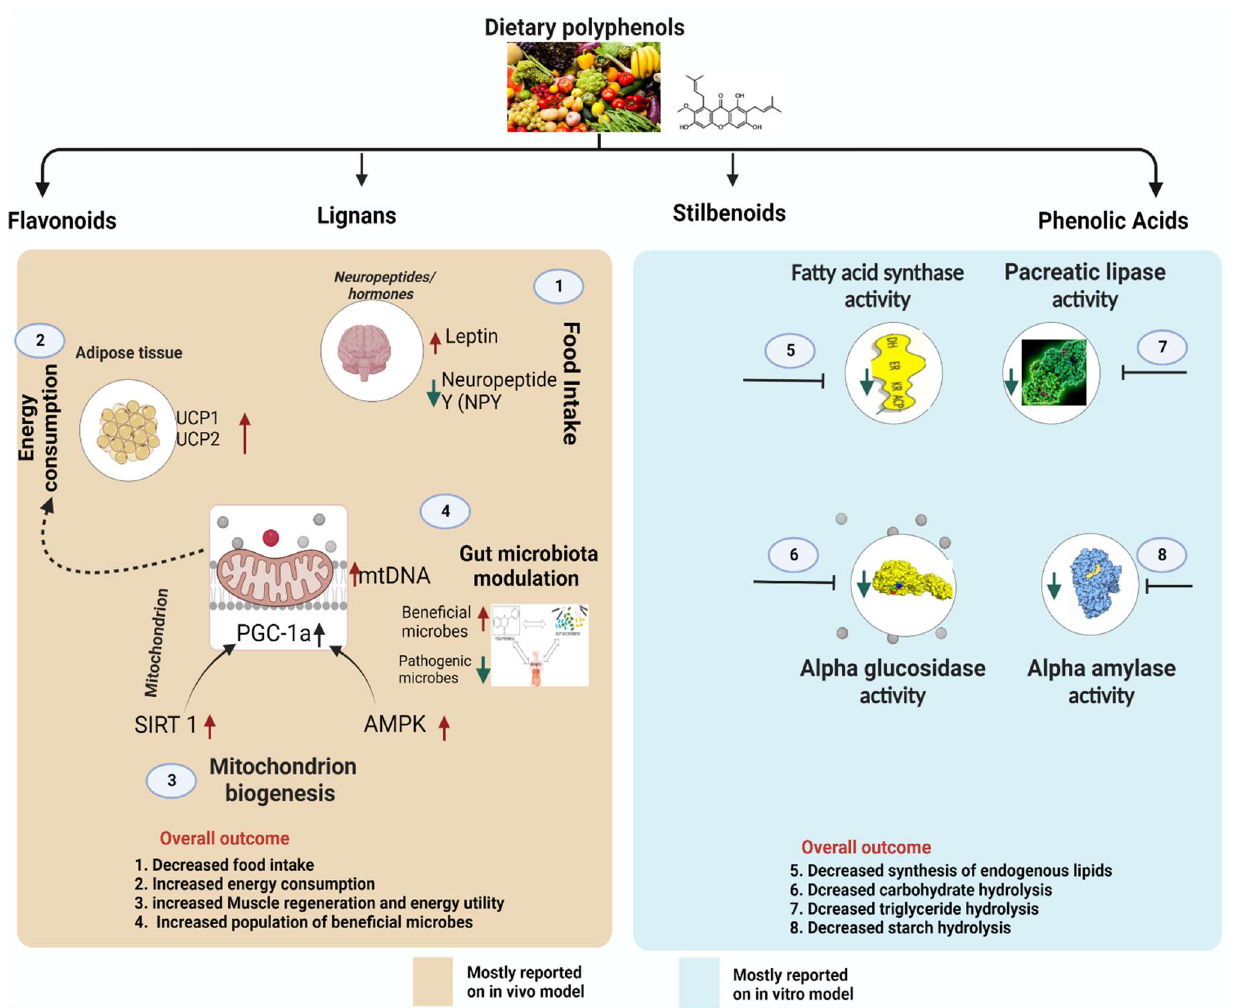
Figure 3. Molecular target and mode of action for antiobesity of polyphenols. ↑ , Up-regulation; ↓ , down-regulation.